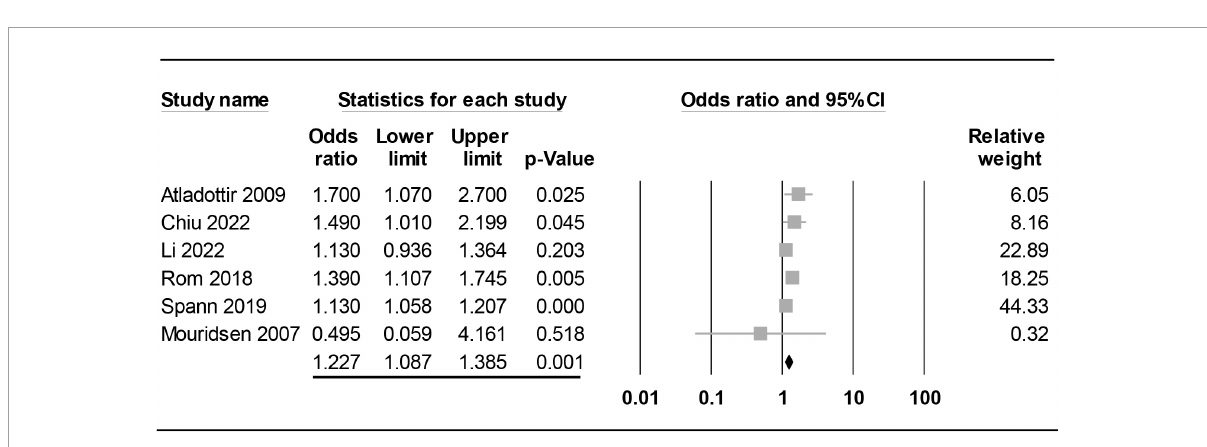
FIGURE6 Forest plot showing association of maternal rheumatoid arthritis (RA) regardless of timing of diagnosis (i.e., before or after childbirth) with risk of offspring autism spectrum disorder (ASD). CI, confidence interval.